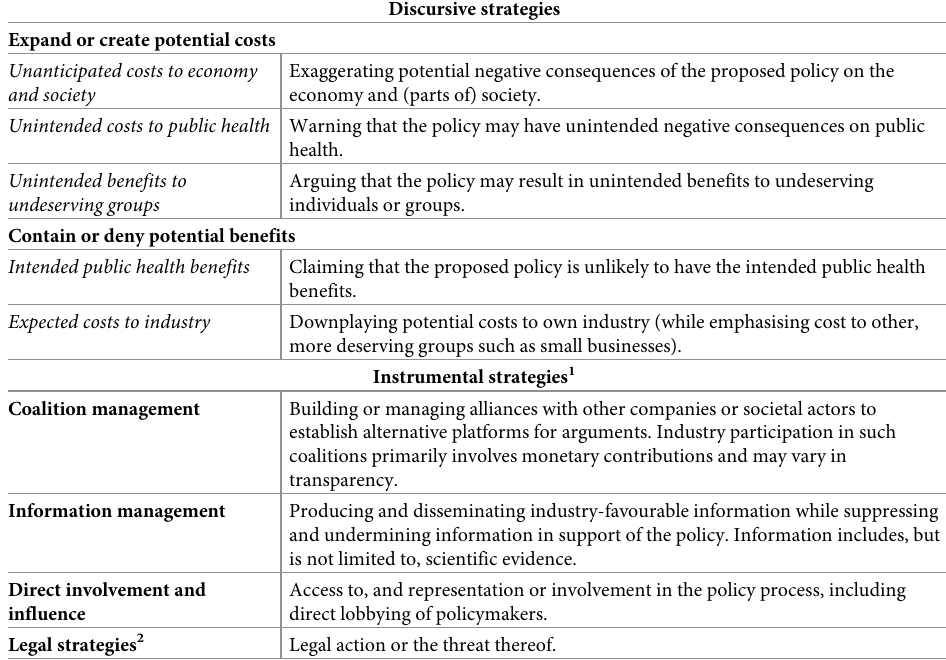
Table 1. Instrumental and discursive strategies from the PDM